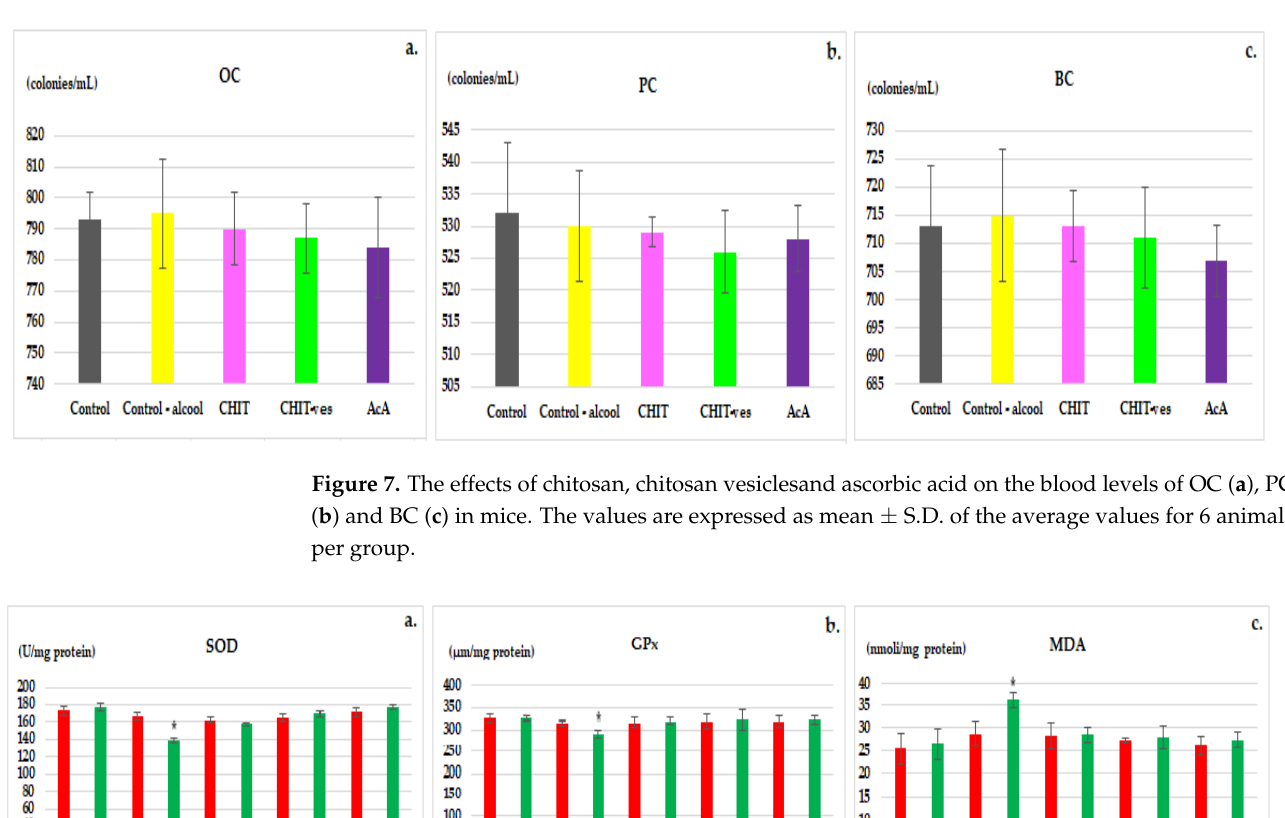
Figure 6. The effects of chitosan, chitosan vesiclesand ascorbic acid on the serum urea ( a ) and cre- atinine ( b ) levels in mice (mean ± S.D. of the average values—groups of 6 animals). OC, PC and BC levels displayed no statistically significant differences in the CHIT, CHIT-ves or AcA group compared to non-alcoholic and alcoholic control animals at the end of the experiment (Figure 7a–c).